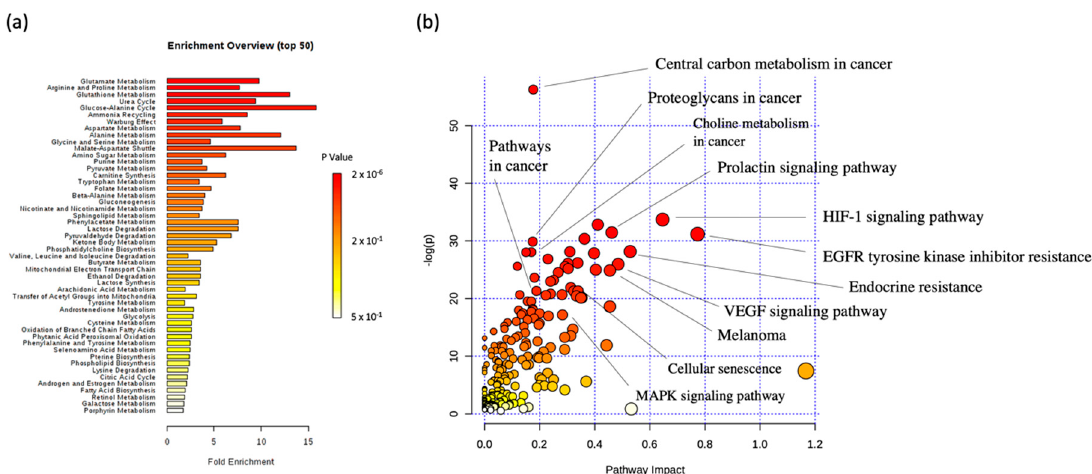
Figure 5. ( a ) Connection of the 15 significantly changed metabolites to metabolic pathways using MSEA. ( b ) Joint pathway analysis of the significantly changed metabolites and proteins, with cancer-related pathways highlighted. The size and color of the circular symbols highlight the pathway impact and p -value, respectively.